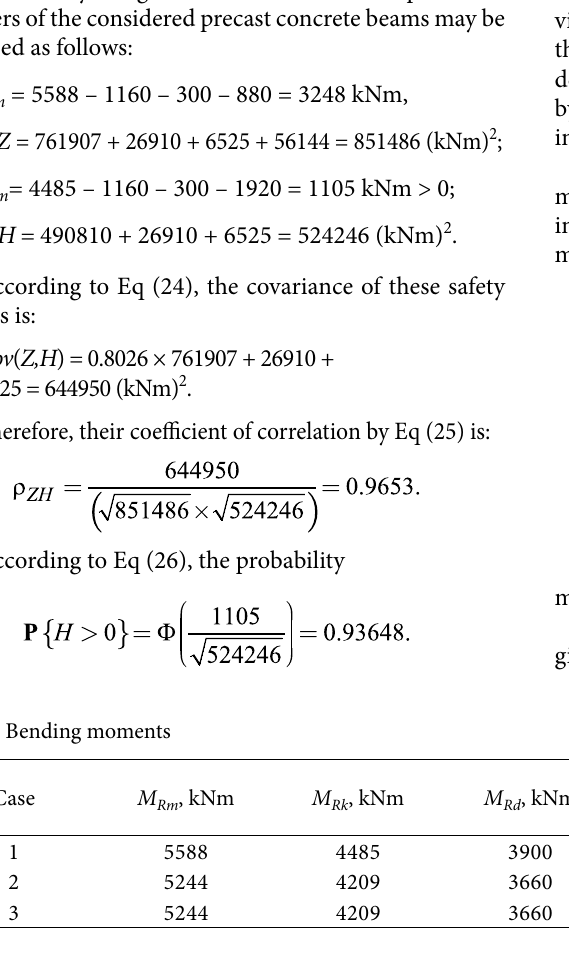
Table 2. Correlation parameters and reliability